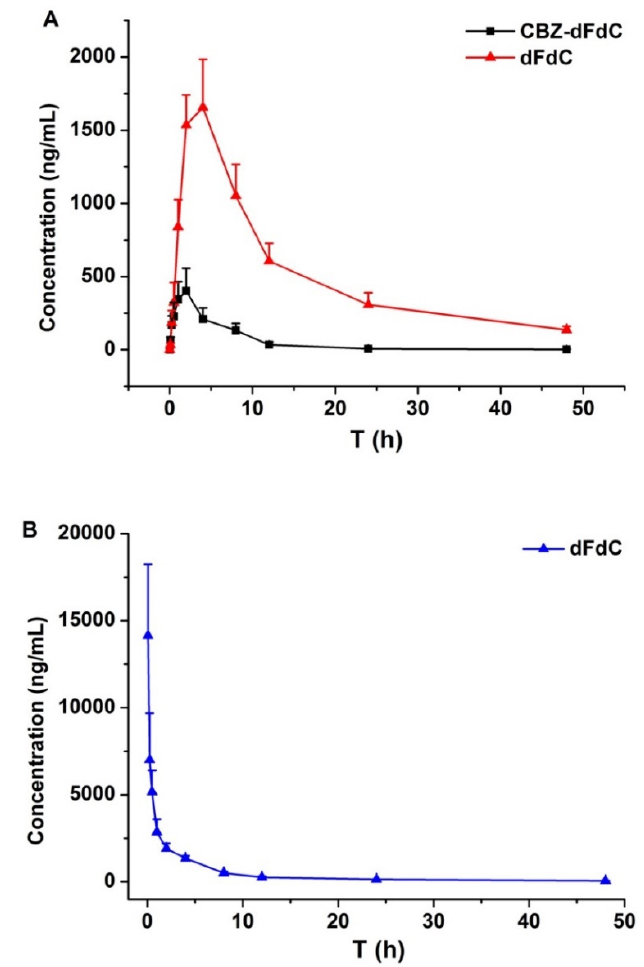
Table 1. Pharmacokinetic parameters of Cbz-dFdC and dFdC.